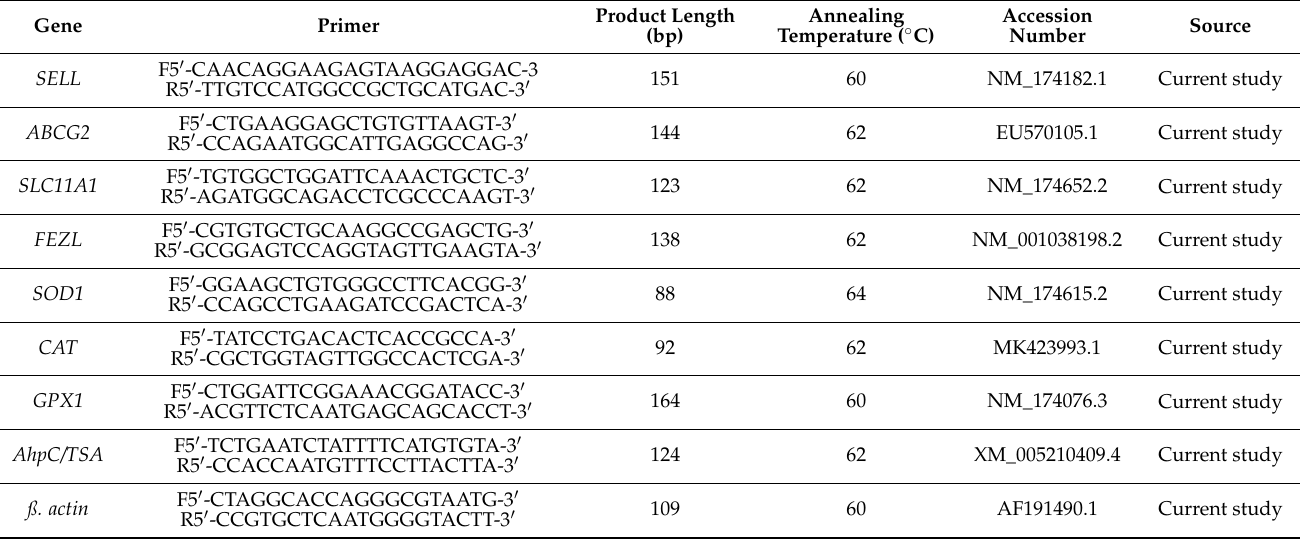
Table 2. Oligonucleotide primers sequence, accession number, annealing temperature and PCR product size of genes used in real-time